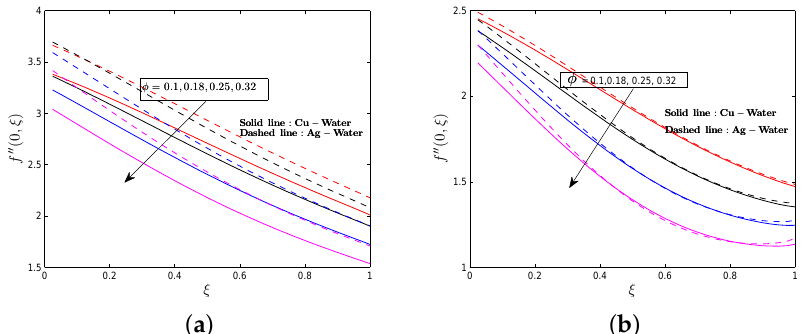
Figure 13. Skin friction coefficient for various values of φ . ( a ) vertical plate; ( b ) horizontal plate.